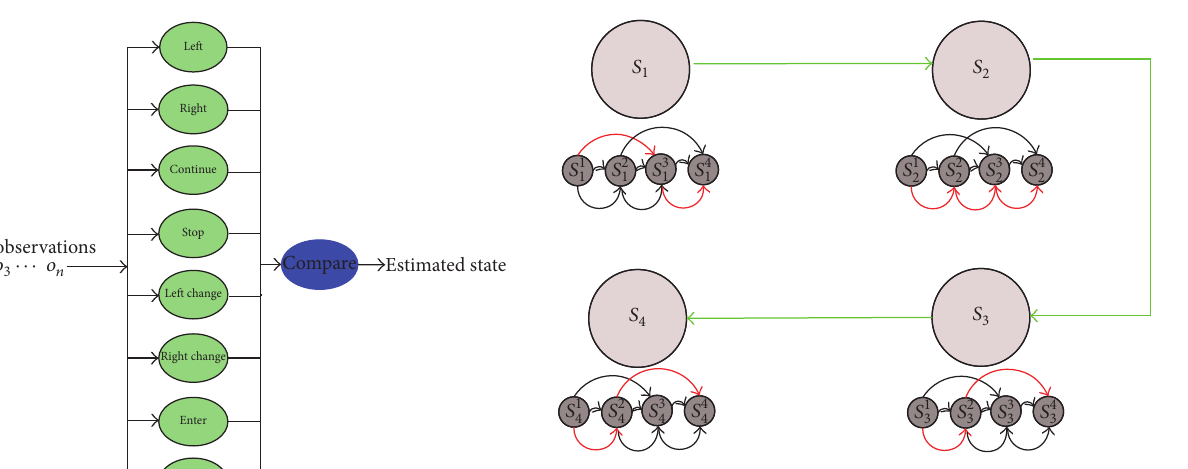
Figure 3: A simple 4-metastate DSS transition. In this example, the green lines correspond to metastate transitions and the red lines correspond to potential underlying state